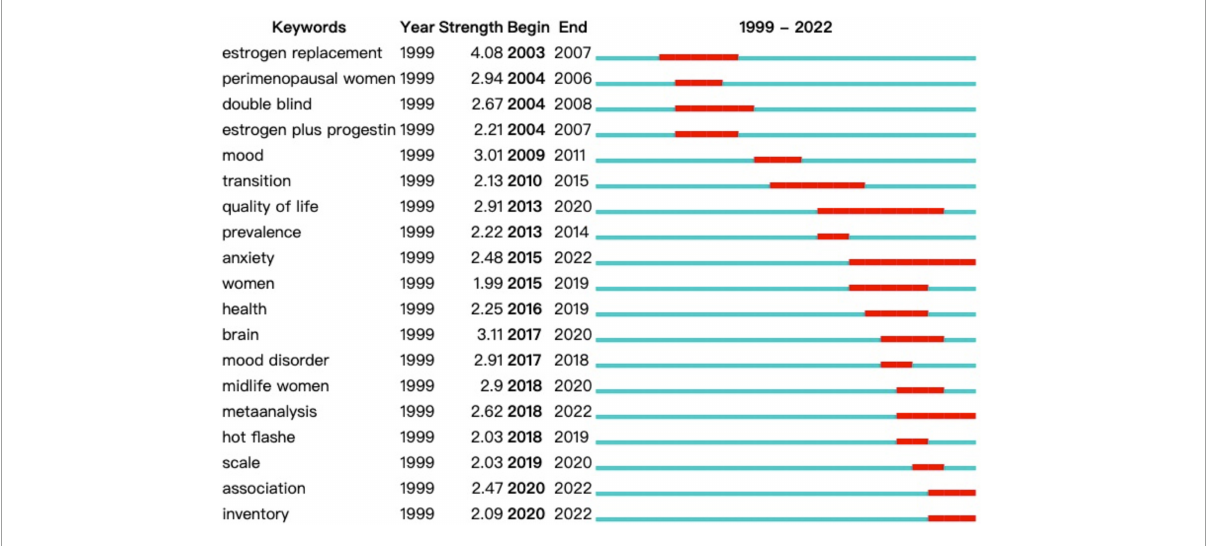
FIGURE10 Keywords with the most robust citation bursts in published articles on